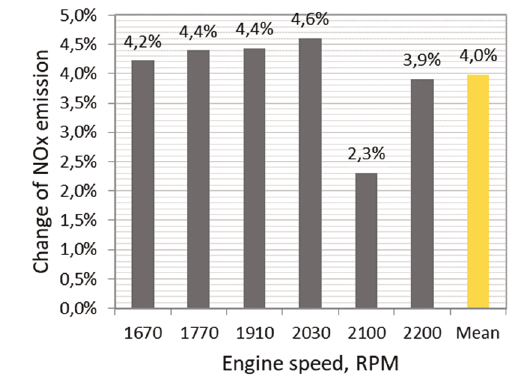
Fig. 16. Differences in NO x emission power between engines with constant and variable ignition advance angle